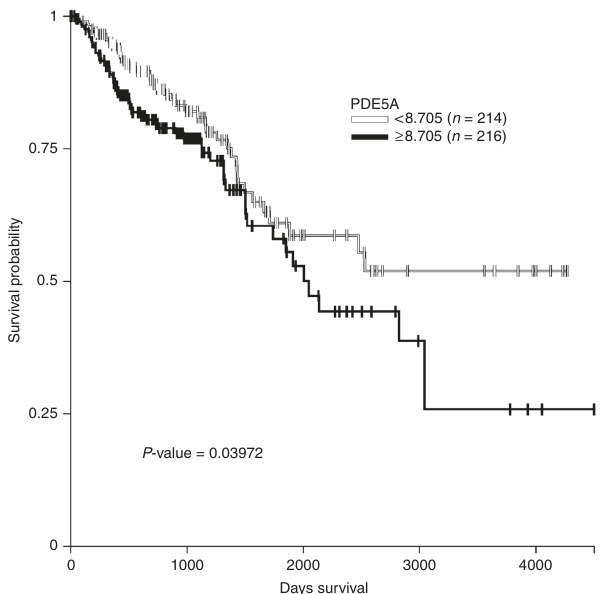
Fig. 1 Overall survival curves strati fi ed by expression of PDE5A gene. Log-rank test was used to compare the difference of survival curves. Data of PDE5A gene expression in patients with colorectal cancer were collected from TCGA colon and rectal cancer, including 214 patients with low expression and 216 patients with high expression for survival curve plot,